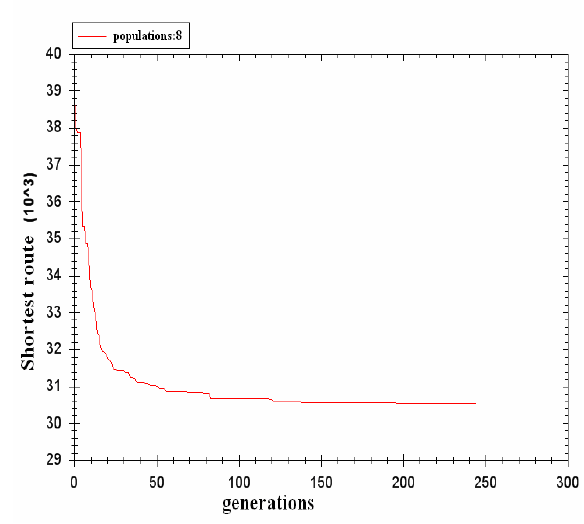
Figure9. The average result 1 of TSP benchmark instances Chn144 by different number of subpopulations